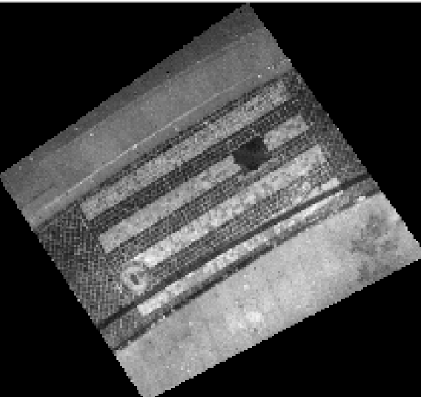
Figure 5. Example of the raster image of a zebra crossing from a point cloud.